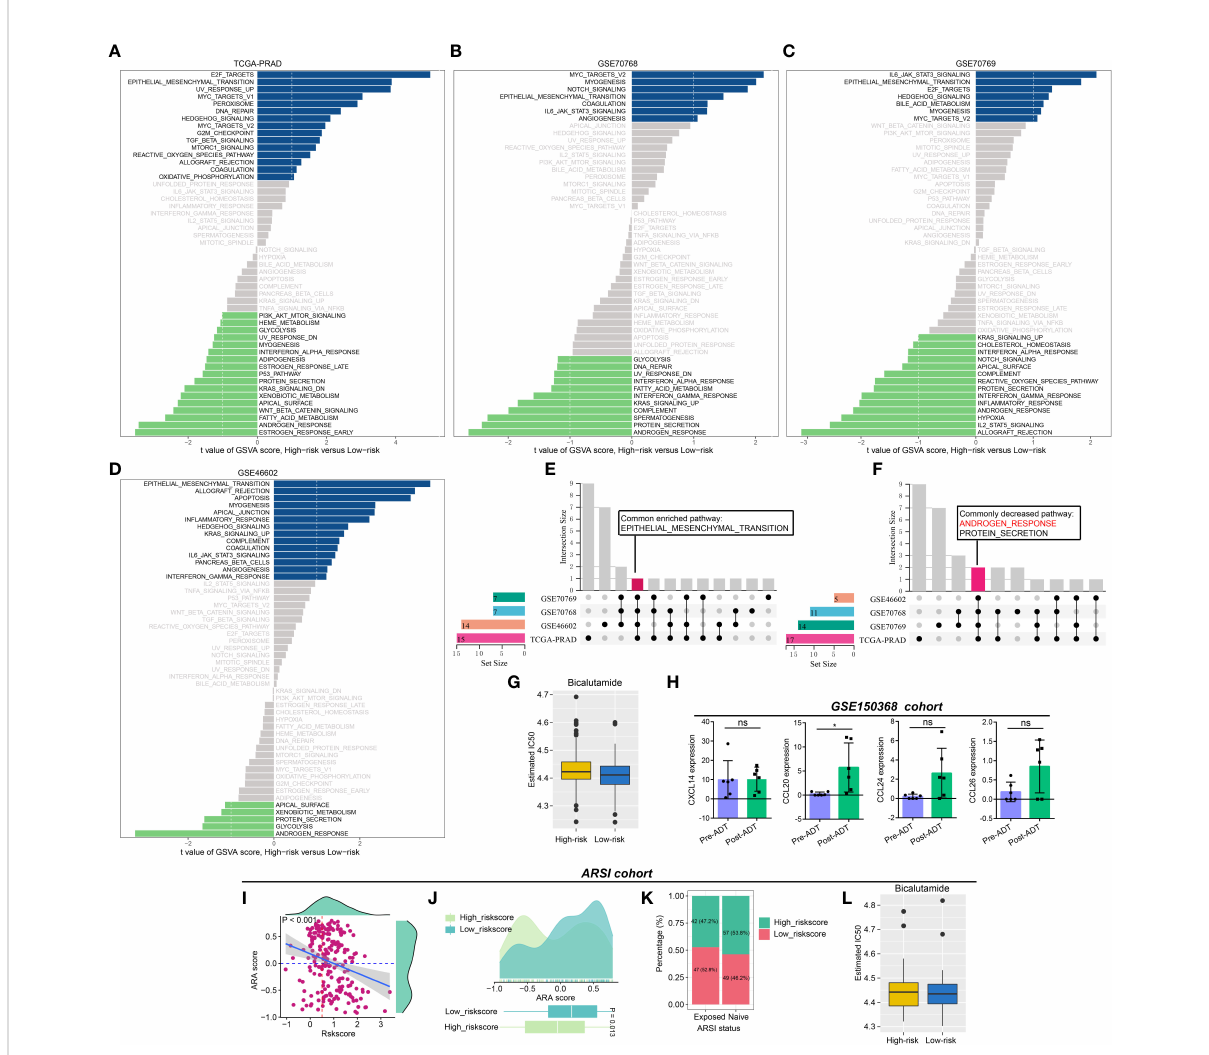
FIGURE 5 Association between CRPGS, androgen response pathway, and ADT response. Results of GSVA between high- and low-risk PCa patients (A – D) , and the Venn diagram showed the common enriched and decreased pathways (E, F) . The estimated IC50 of bicalutamide between high- and low-risk patients in TCGA-PRAD cohort (G) . The alterations in the expression level of CXCL14, CCL20, CCL24, and CCL26 after ADT treatment in the GSE150368 cohort (H) . The association between CRPGS, ARA score, and ARSI exposure status (I – K) , and the estimated IC50 of bicalutamide between high-and low-risk patients in Abida et al ’ s cohort (L) . *p < 0.05; ns, not signi fi